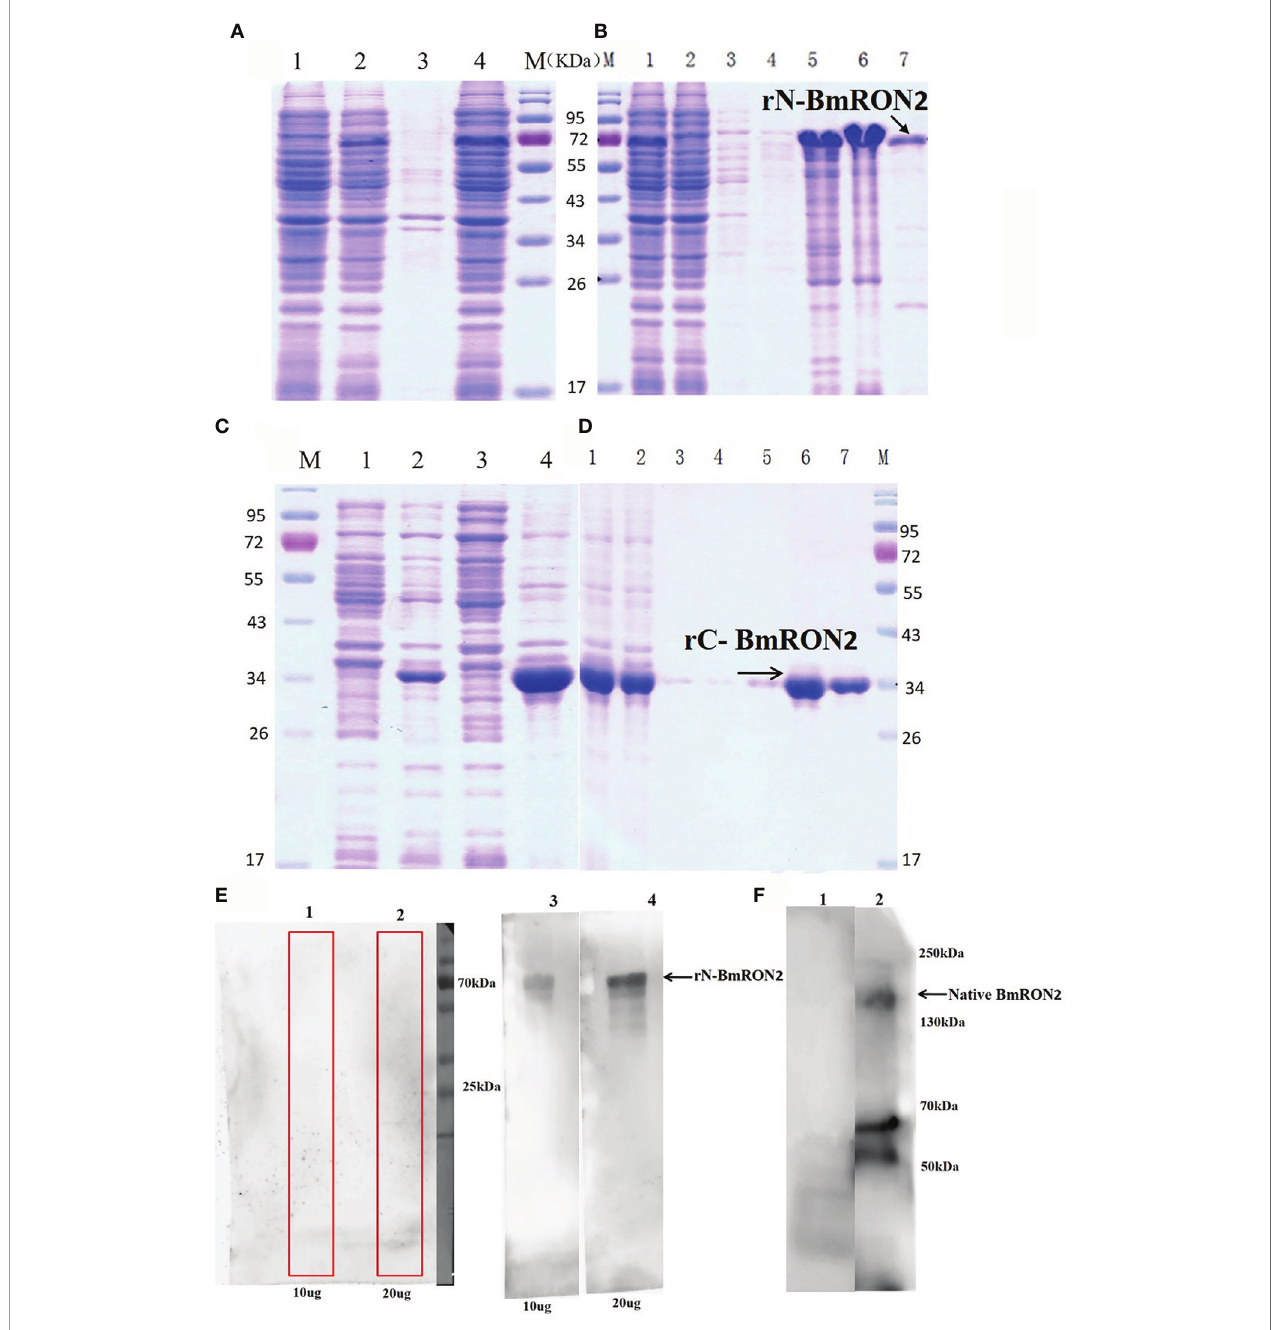
FIGURE 2 | SDS-PAGE and Western blot analysis of native and recombinant BmRON2 proteins. (A) (N- BmRON2). M, Protein markers; A1, Uninduced cells, A2, IPTG-induced cells, A3, Supernatant, A 4, Precipitate. (B) (N- BmRON2). M, Protein markers; B1, Pre-puri fi ed protein, B2, Flow through, B 3-7, Different concentrations of puri fi ed protein. (C) (C- BmRON2). M, Protein markers; C1, Uninduced cells, C2, IPTG-induced cells, C3, Supernatant, C 4, Precipitate. (D) (C- BmRON2). M, Protein markers; D1, Pre-puri fi ed protein, D2, Flow through, D 3-7, Different concentrations of puri fi ed protein. (E) Western blot analysis of rN- BmRON2. E1-2, rN-BmRON2 protein tested with normal mouse serum; E3-4, rN-BmRON2 protein tested with serum from a B. microti -infected mouse. (F) Western blot analysis of native BmRON2. F1, Uninfected RBCs protein extract tested with rabbit polyclonal anti- rN-BmRON2 antibody, no bands were detected; F2, iRBCs protein extract tested with rabbit polyclonal anti- rN-BmRON2 antibody, a speci fi c band of approximately 170 kDa, plus two additional bands of about 55 kDa to 70 kDa were detected in this sample, suggesting proteolysis of